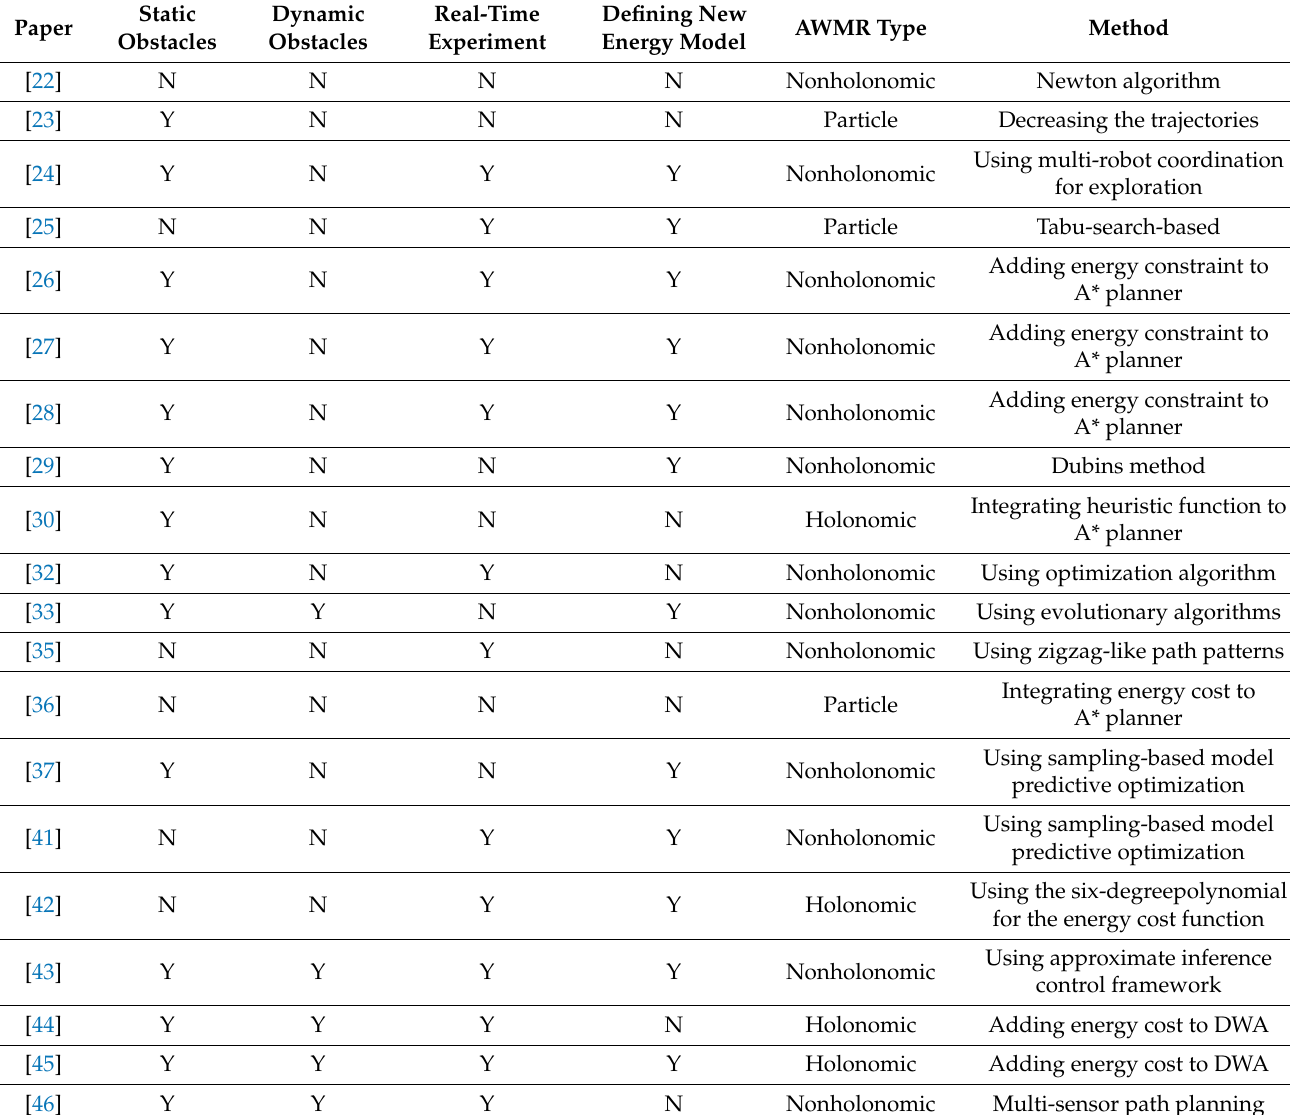
Table 1. Overview of papers on planning related to energy, with a summary of the methods